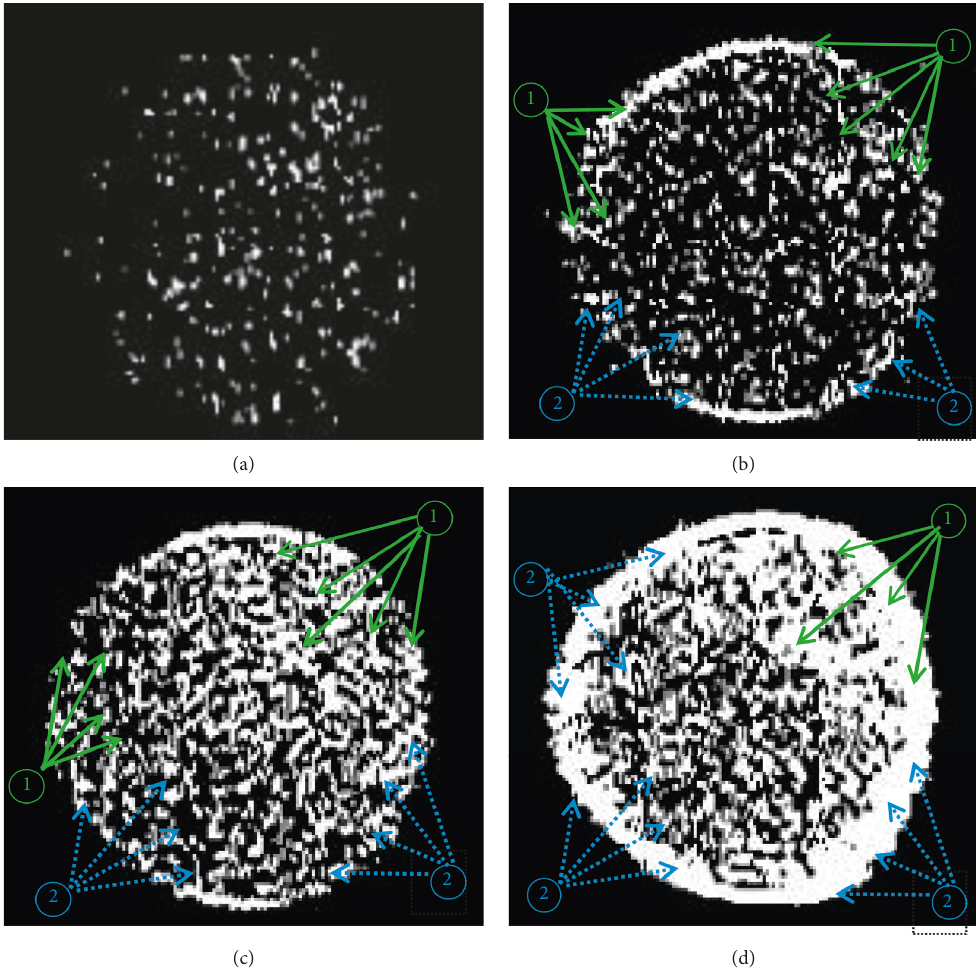
Figure 7: Images of sandstones of the H 2 SO 4 solution group after different numbers of freeze-thaw cycles: (a) 0; (b) 10; (c) 20; (d) 30. Two different kinds of pore deformation are approximately labelled by ① which indicates new pores are generated and ② which indicates pores are deformed to larger